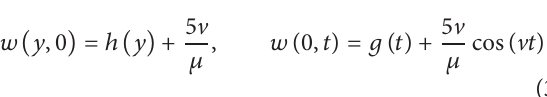
with the initial-boundary